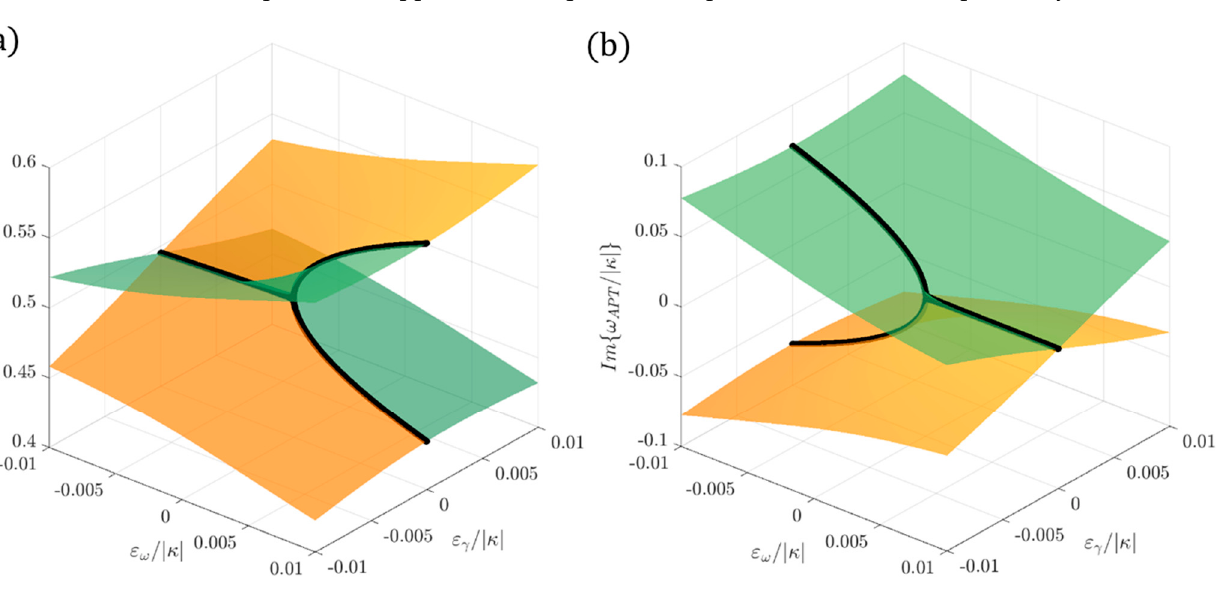
Figure 4. The real part ( a ) and imaginary part ( b ) of the eigenfrequencies of an anti-PT-symmetric Hamiltonian for different values of the perturbations ε ω and ε γ in the proximity of an EP. Black lines identify the region where ε γ = 0.